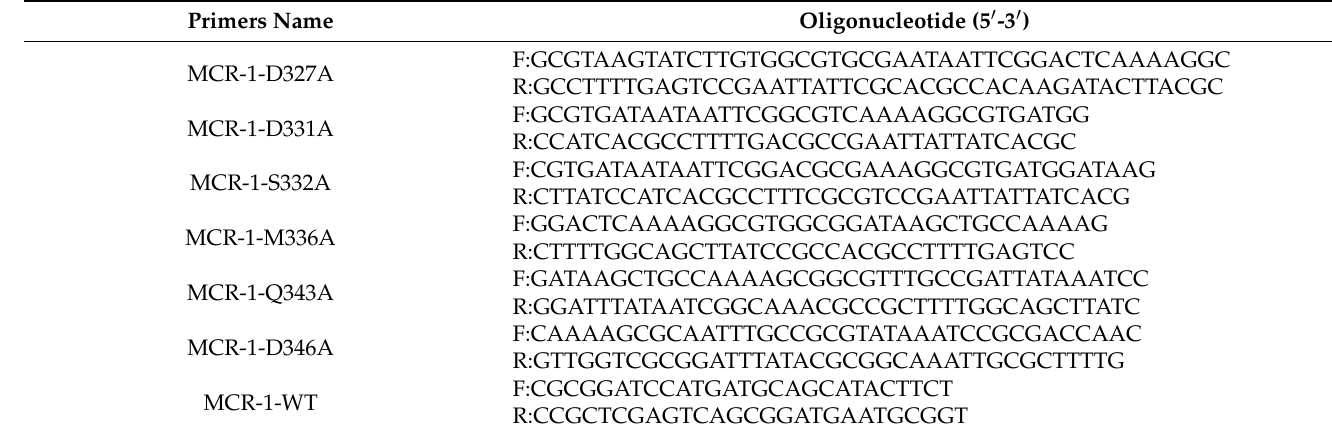
Table 2. The primers of mcr-1 and its mutants used for common